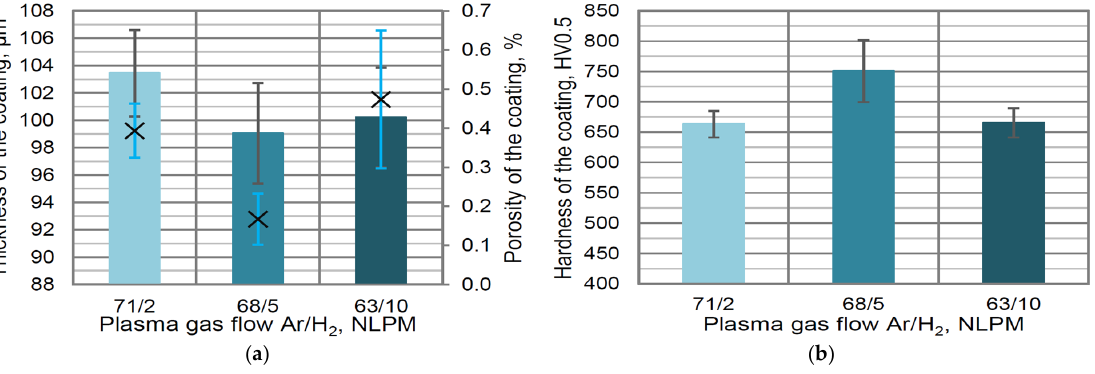
Figure 4. The influence of plasma gas composition on thickness/porosity (in the figure, the mean value of the porosity is marked as ×) ( a ) and hardness ( b ) of developed coating containing 10 wt. % YSZ additions.